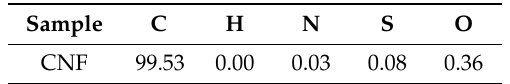
Figure 1. TEM images of carbon nanofibers (CNF) (graphitic structure is observed). Table 1. CNF elemental analysis (wt %). Table 1. CNF elemental analysis (wt %).